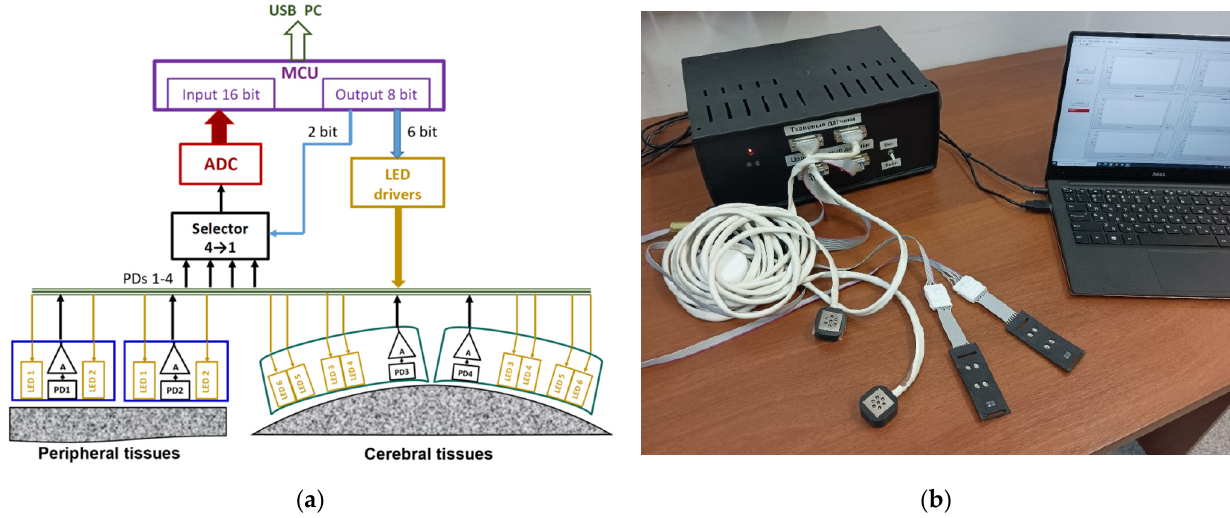
Figure 3. ( a ) Top-level architecture of the multifunctional oximeter; ( b ) the photograph of the mul- tifunctional oximeter prototype. multifunctional oximeter